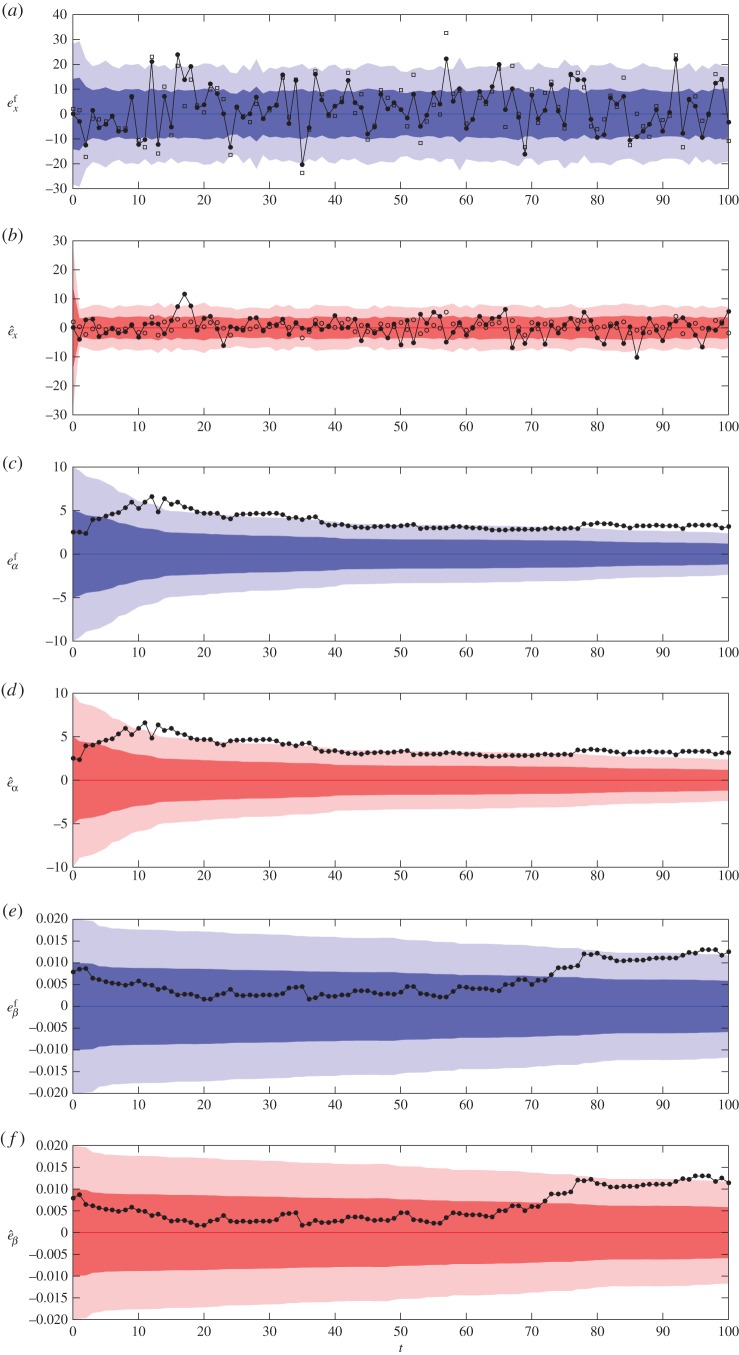
Forecast (blue) and analysis (red) errors for sequential parameter estimation of the simple box model. (a,b) The corresponding errors for x, (c,d) for α and (e,f) for β. More details are included in the main text.